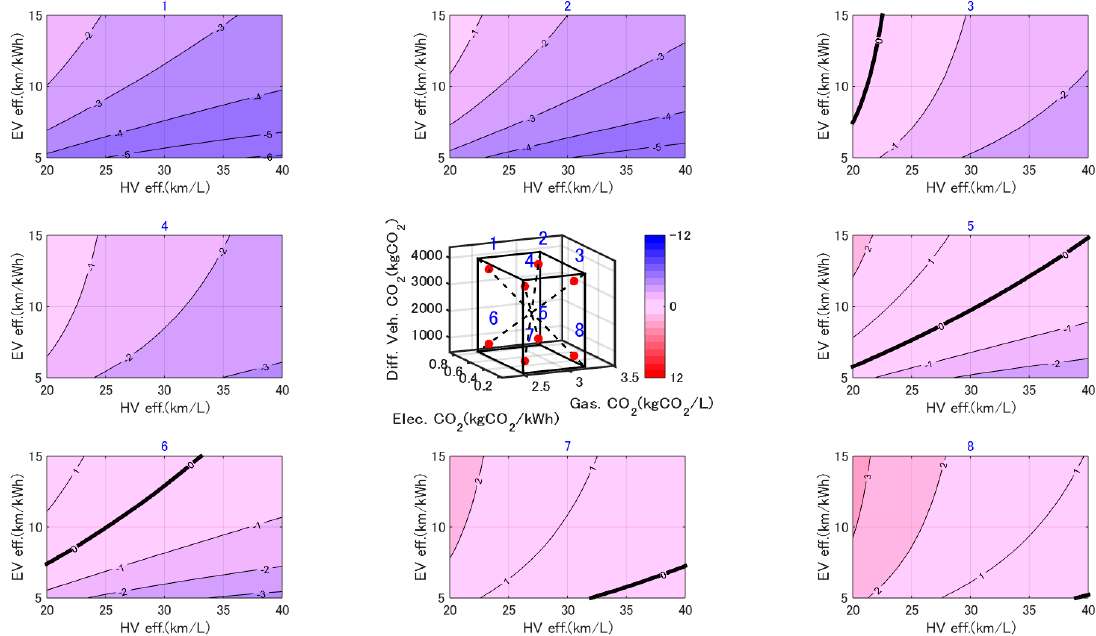
Figure 7. Five-dimensional diagram of LCCO 2 comparison emphasizing vehicle efficiency with difference of vehicle CO 2 emissions during production ∆ D set to 500 kg.